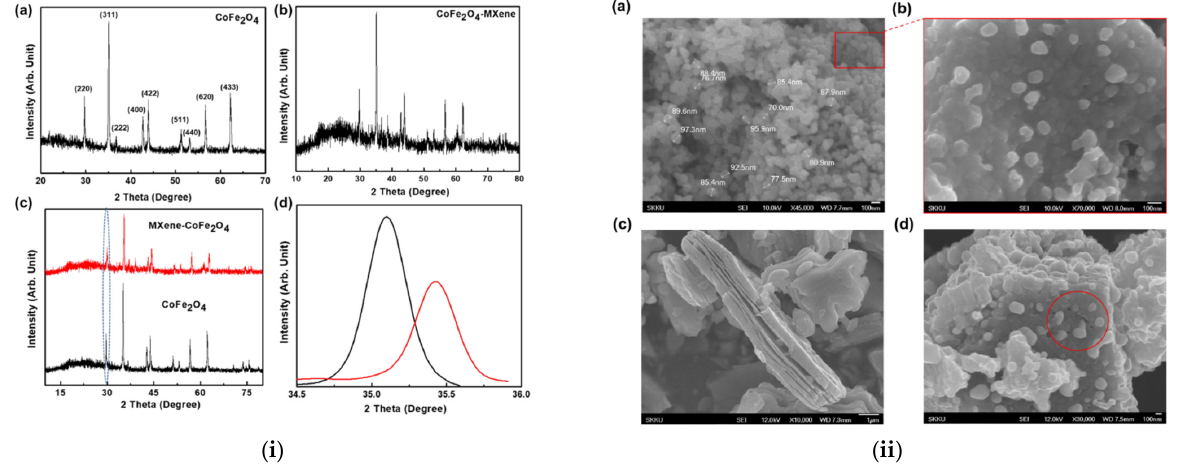
Figure 10. ( i ) XRD pattern of ( a ) Co ferrite, ( b ) MXene/Co-ferrite, ( c ) comparison pattern, and ( d ) magnified at lower angle, and ( ii ) SEM micrograph of ( a , b ) Co-ferrite, ( c ) MXene and ( d ) MXene/Co-ferrite nanocomposite. Reproduced with permission from [24] Copyright (2020) American Chemical